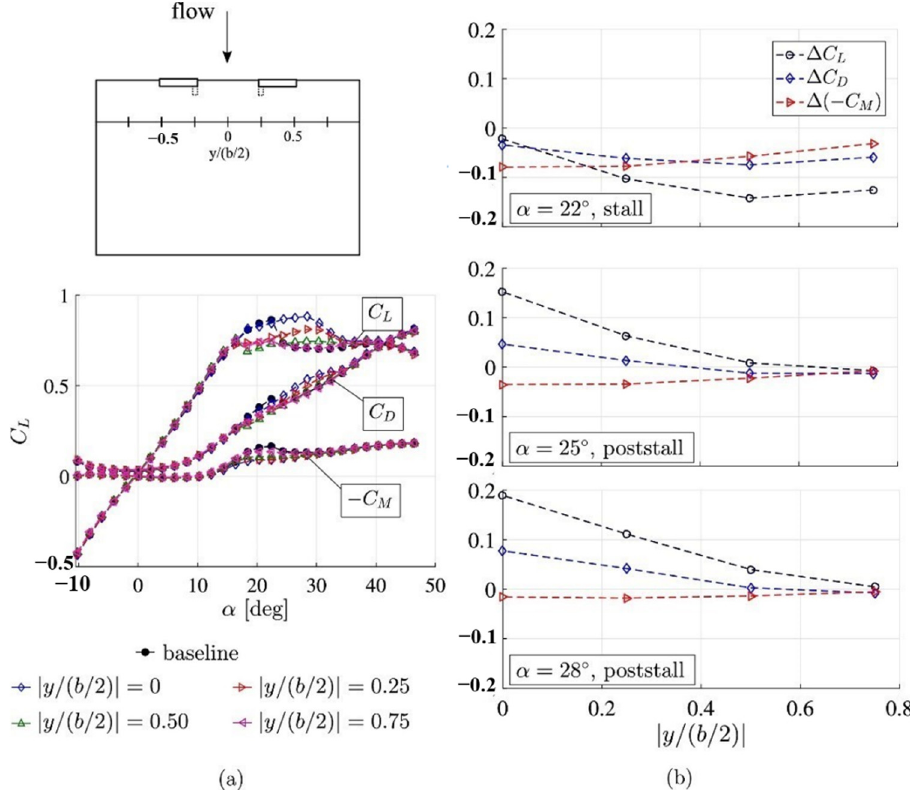
Figure 9. ( a ) Lift, drag, and pitch moment coefficient as a function of angle of attack for dual-opposing alulae placed at various spanwise locations. ( b ) Change in lift, drag, and pitch moment coefficient relative to baseline wing as a function of the spanwise location of the alula [22].